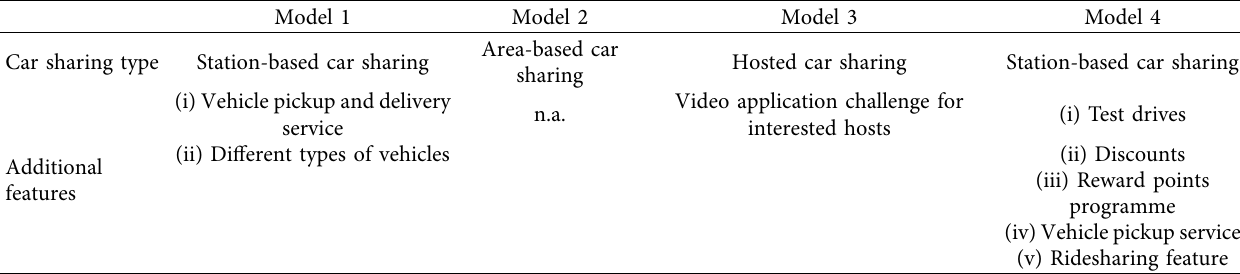
Table 5: Results from cocreation workshop to develop an electric car sharing model ( n �